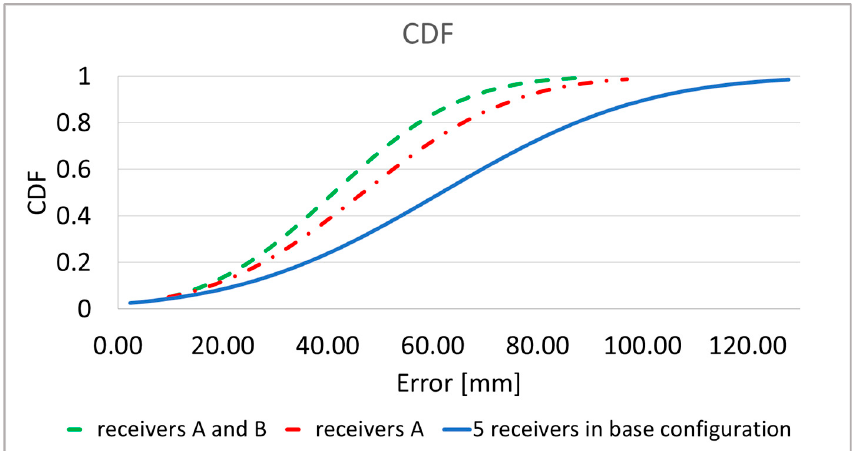
Figure 17. Cumulative distribution function (CDF) of localization error for algorithm with adaptive receivers selection. Results for 160 capsule positions in the digestive tract.